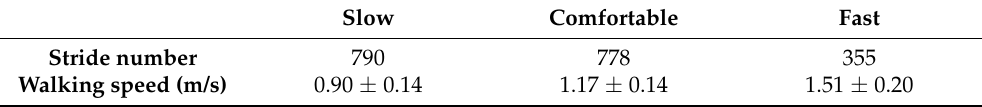
Table 1. Number of analyzed strides and averaged walking